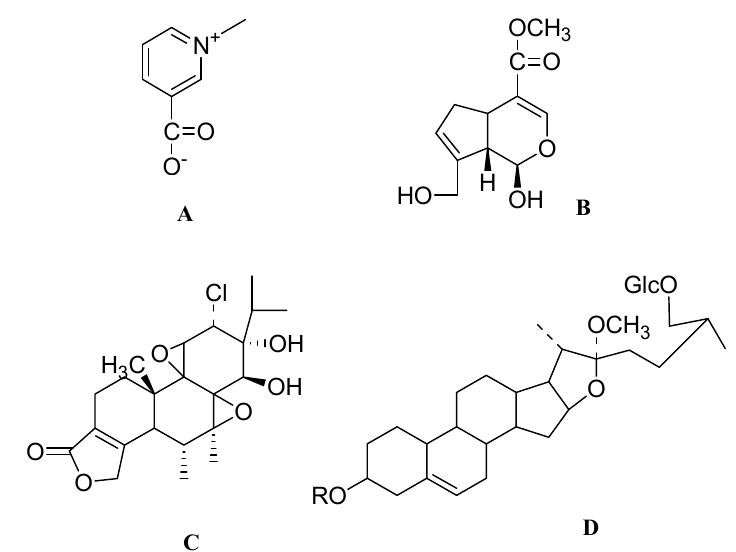
Figure 7. The molecular structures of trigonelline ( A ), genipin ( B ), tripchlorolide ( C )